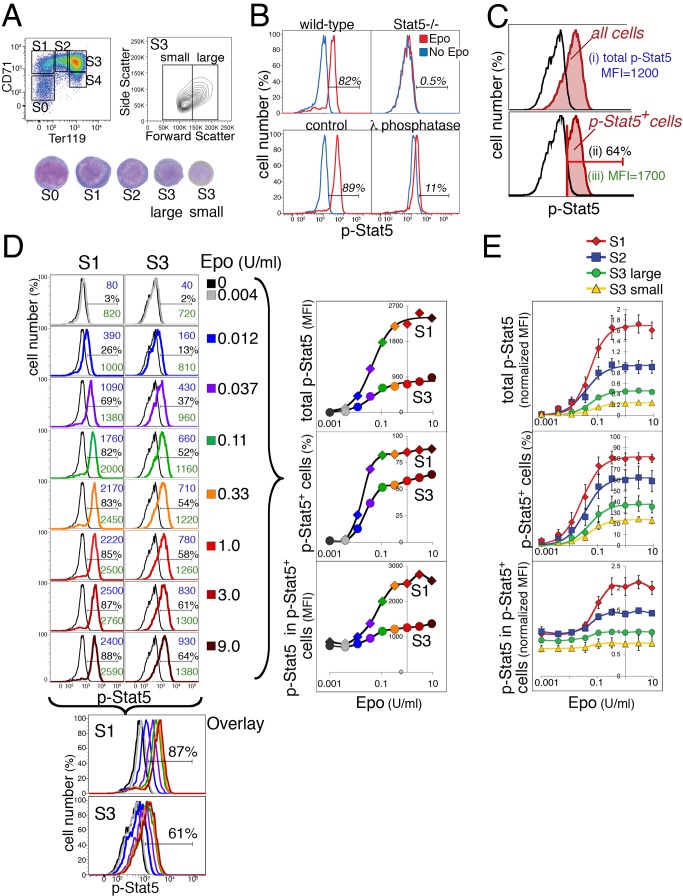
The p-Stat5 response in fetal liver.(A) Flow cytometric Ter119/CD71 profile of freshly isolated fetal liver
at E13.5, fixed and permeabilized in preparation for intracellular
p-Stat5 measurements. Subsets S0 to S4 (left histogram) contain
erythroblasts of increasing maturation, as seen from their morphological
appearance in cytospin preparations (stained with Giemsa and
diaminobenzidine). The right histogram shows the further division of S3
cells into small and large subsets based on the flow-cytometric
“forward scatter” parameter. (B) Specificity of the Alexa
647-conjugated anti-p-Stat5 antibody (BD Biosciences # 612599). Upper
panels, response of S1 cells from either wild-type or
Stat5−/− fetal livers to Epo stimulation (2
U/ml) for 15 min (red histograms). Blue histograms are baseline
fluorescence in the absence of Epo. Lower panels, Epo-stimulated (2
U/ml; 15 min, red histograms) or unstimulated (blue histograms) S1 cells
in wild-type fetal liver, either treated or untreated with
λ-phosphatase prior to p-Stat5 staining. Numbers in all panels
indicate the fraction (%) of p-Stat5 positive cells within the
indicated horizontal gates. (C) The three measures used to analyze the
p-Stat5 response to Epo (9 U/ml, 15 min, red histogram) in S3
erythroblasts. The black histogram corresponds to pre-stimulation cells
of the same subset. (i) “total p-Stat5 median fluorescence
intensity (MFI)” (upper panel), the p-Stat5 MFI of
the entire S3-subset population, represented by the shaded red
histogram. This measure does not distinguish between signaling and
nonsignaling cells. (ii) “p-Stat5+
cells(%)” (lower panel), cells within the
p-Stat5+ gate, shaded in red, expressed as a
fraction (percent) of all cells in the Epo-stimulated S3 subset. This is
an estimate of the number of signaling cells. The placement of the
p-Stat5+ gate was determined by reference to the
baseline, pre-stimulation histogram (in black), so that no more than
1% of the unstimulated population is included within the
p-Stat5+ gate. (iii) “p-Stat5 in
p-Stat5+ cells” (lower panel),
estimates the p-Stat5 MFI in signaling cells only. (D) Response of S1
and S3 erythroblasts to Epo stimulation. Freshly isolated fetal liver
cells were deprived of Epo for 90 min and were then stimulated with a
range of Epo concentrations as indicated, from 0.004 to 9 U/ml, for 15
min. Colored flow-cytometry histograms correspond to Epo-stimulated
cells, black histograms in each panel correspond to unstimulated cells
(Epo = 0). An overlay of the responses is shown in
the two lowest panels. For each Epo concentration, three measures of the
p-Stat5 response, as illustrated in (C), are noted next to each
flow-cytometry histogram in blue, black, and green, corresponding to the
total p-Stat5 MFI, to the p-Stat5+ cells (%), and
to the p-Stat5 in p-Stat5+ cells, respectively. Each of
these measures is then plotted as a function of Epo concentration (right
panels); the color of each symbol in these plots corresponds to the
color of the respective flow-cytometry histogram for the same Epo
concentration. (E) The p-Stat5 response to a range of Epo concentrations
at 15 min post-stimulation. Summary of five independent experiments
similar to Panel D. Data (mean ± SE) for each experiment were
normalized by expressing each p-Stat5 MFI reading as a ratio to the
p-Stat5 MFI in p-Stat5+ cells of the “S3
large” subset following stimulation with 1 U/ml Epo for 15 min.
Data in the upper two panels were fitted with Hill curves.